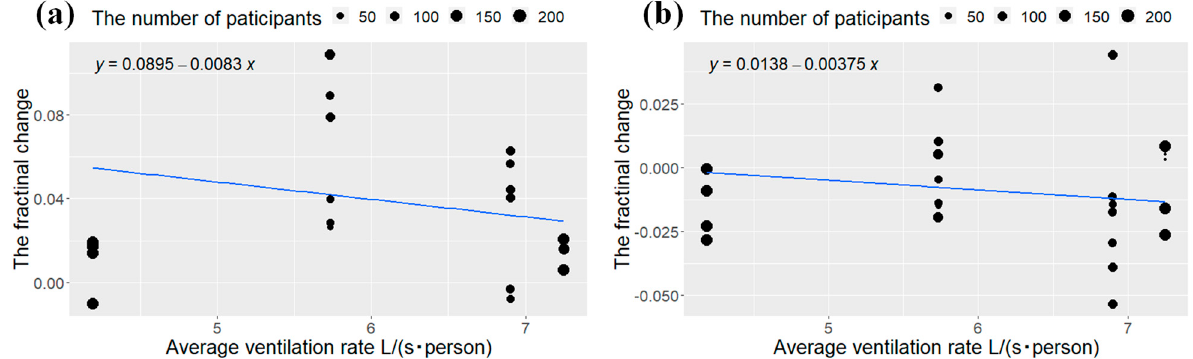
Figure 4. Dose-response relationship between ventilation rate and performance of intelligent tests: ( a ) the task performance speed; and ( b ) the error rate. Each point in these figures represent the change in performance with an increase in ventilation rate of 1 L/(s · person) from the average ventilation rate. The size of these points depends on the sample size of the studies. The blue line is a regression line.